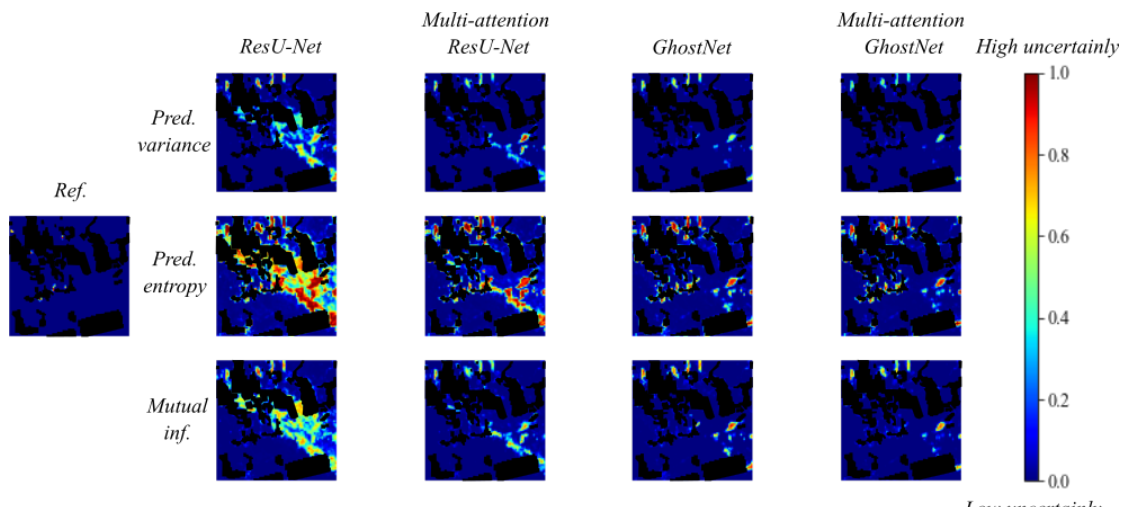
Figure 6. Uncertainly maps of snip c), From left to right: reference; uncertanty maps (ResU-Net, Multi-attention ResU-Net, GhostNet, Multi-attention GhostNet). The rows correspond to: predictive variance, entropy and mutual information. Blue and red colors represent lower and higher uncertainly scores, black regions correspond to past-deforestation